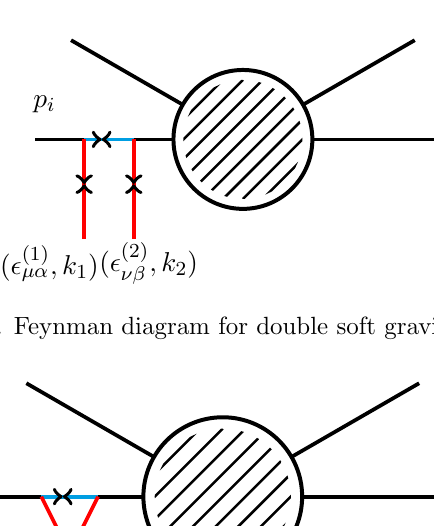
Figure 3 . Feynman diagram for double soft gravitini | I.